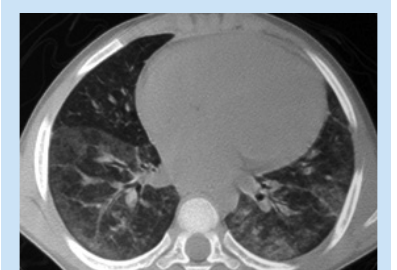
Fig. 22a. Idiopathic pulmonary haemosiderosis.